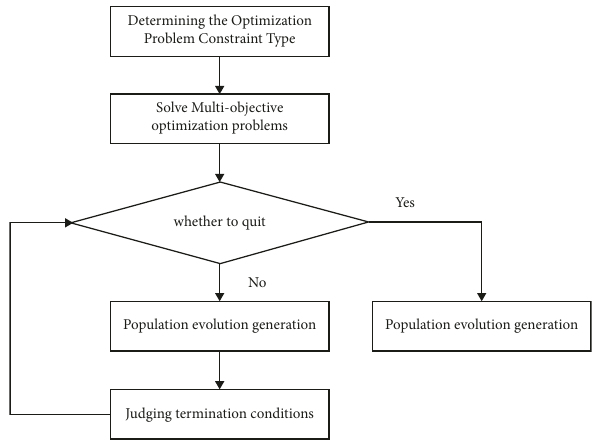
Figure 1: Chromosome